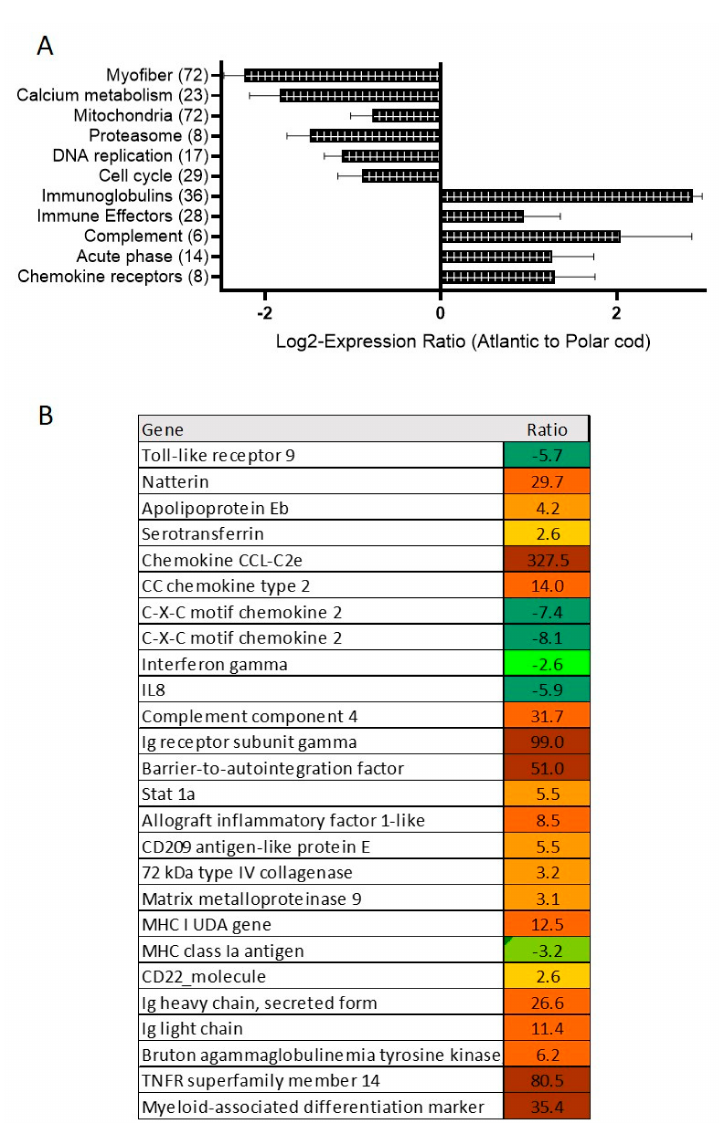
Figure 3. Microarrays, comparison of Atlantic cod and polar cod. Positive and negative values mean higher and lower expression in Atlantic cod to polar cod. ( A ) Functional groups with significant di ff erences between species ( t -test, p < 0.05). Numbers of di ff erentially expressed genes are indicated in brackets; ( B ) Di ff erentially expressed immune genes between the two species, shades of color indicate di ff erent grade of up-regulation (red) or down-regulation (green). Data are log 2